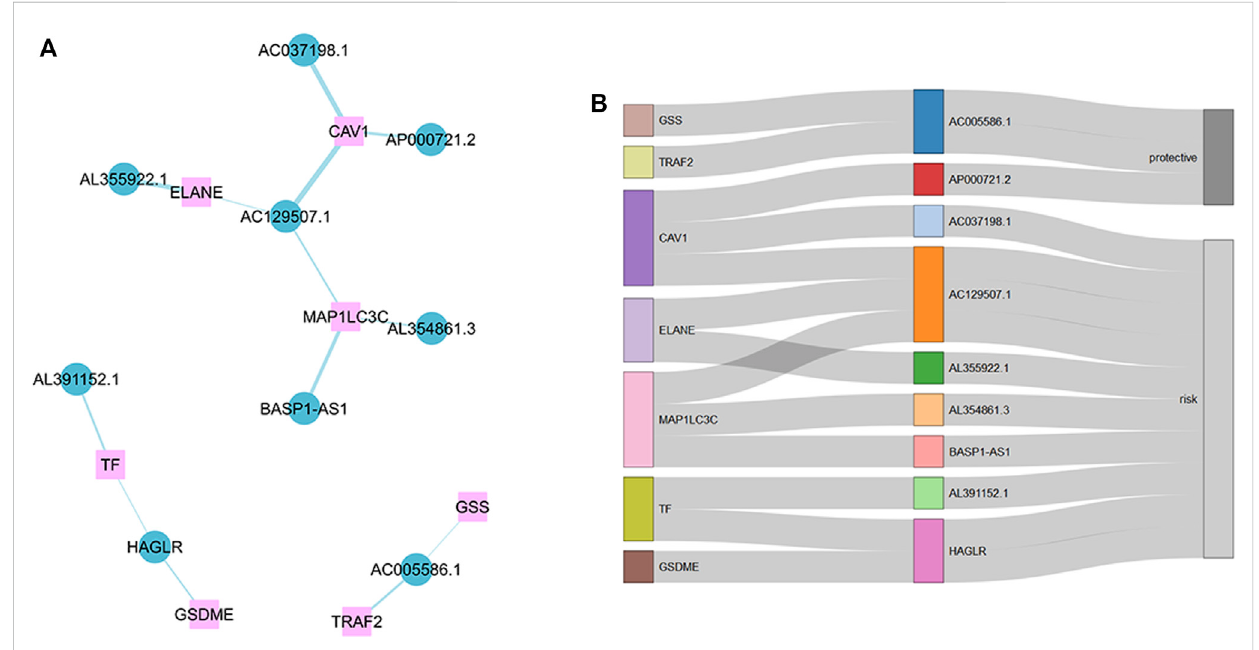
FIGURE 2 Messenger RNA (mRNA) – lncRNA co-expression network. (A) mRNA – lncRNA co-expression network of the ICD-related genes and selected ICD- related lncRNAs. (B) Sankey diagram showing connection degree between ICD-related lncRNAs and ICD-related